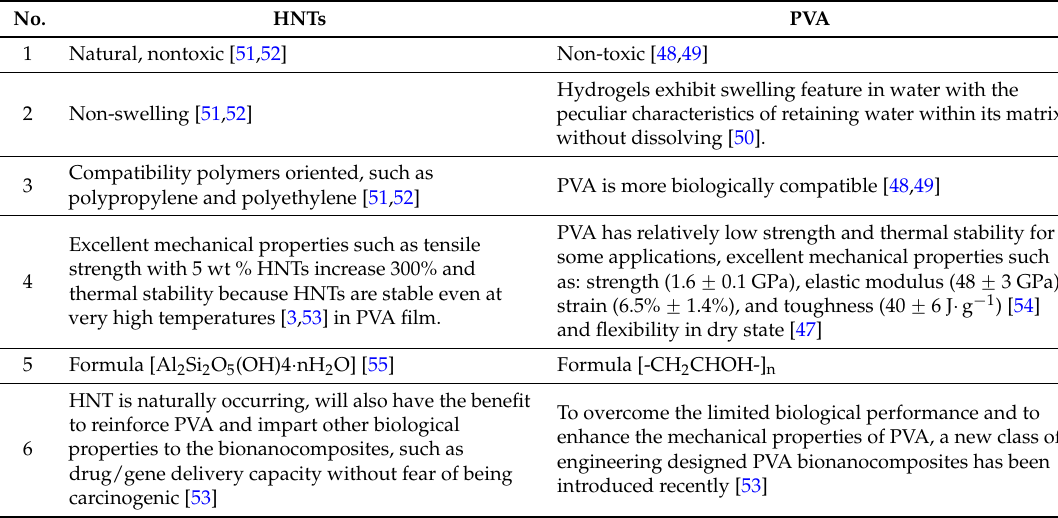
Table 1. Summary of main properties.